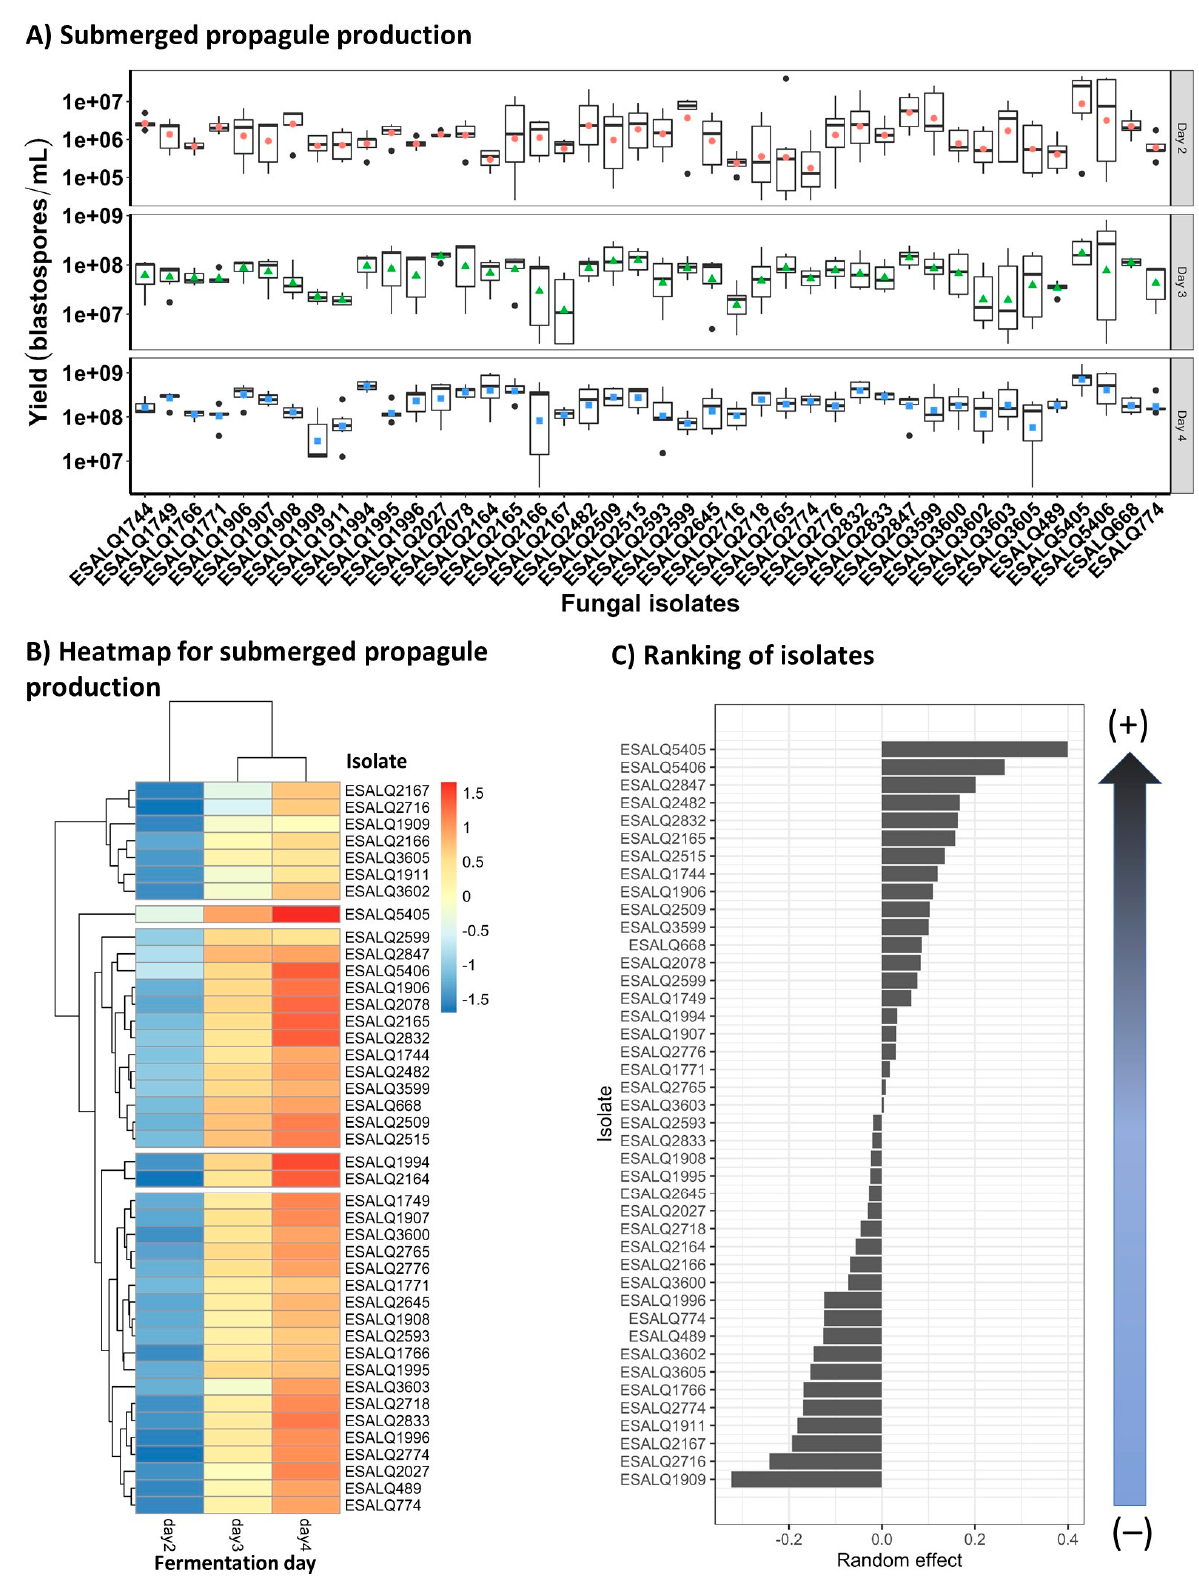
Figure 2. Boxplots (colored symbols are mean values and bold horizontal lines are medians for fungal isolates within each fermentation day) and heatmap and a graph rank depicting a gradient between strongest and weakest fungal isolate producers for predicted mean concentration of submerged propagules (blastospores) of Purpureocillium lilacinum and Pochonia chlamydosporia on